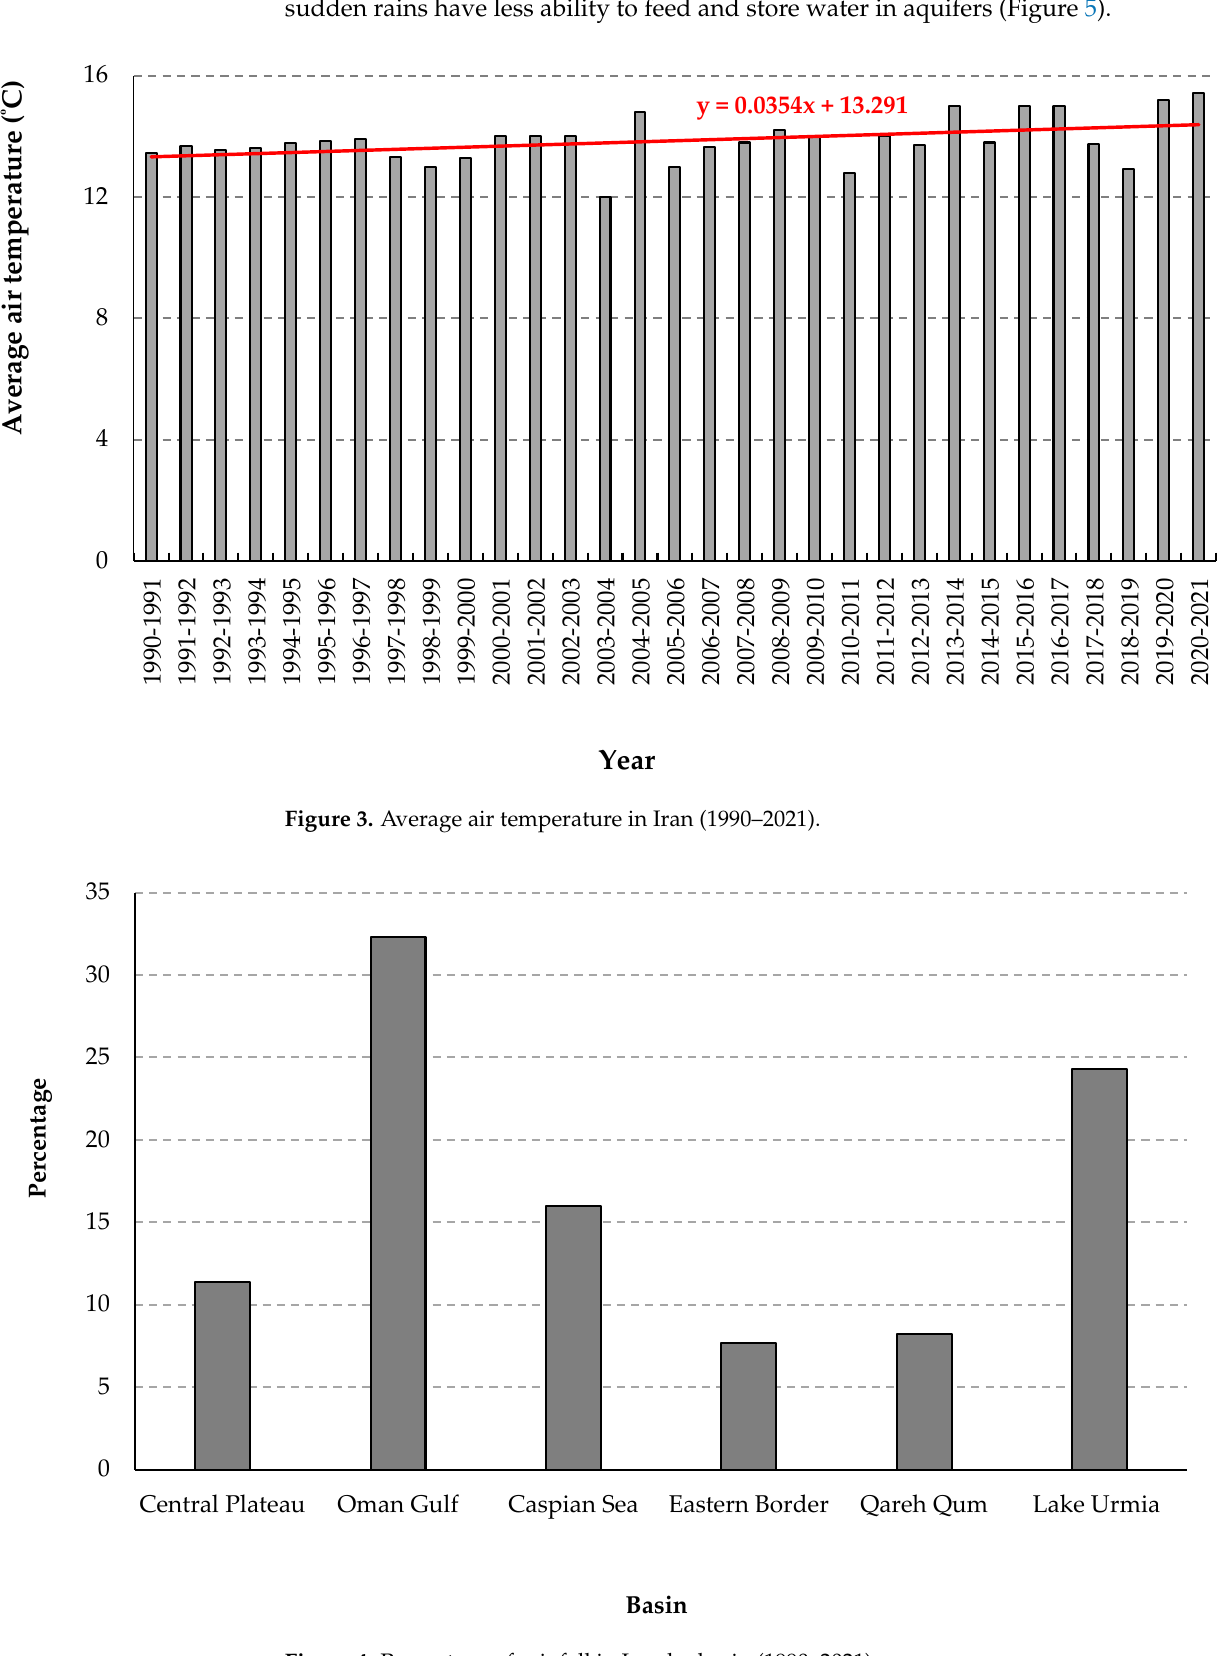
Figure 4. Percentage of rainfall in Iran by basin (1990–2021).